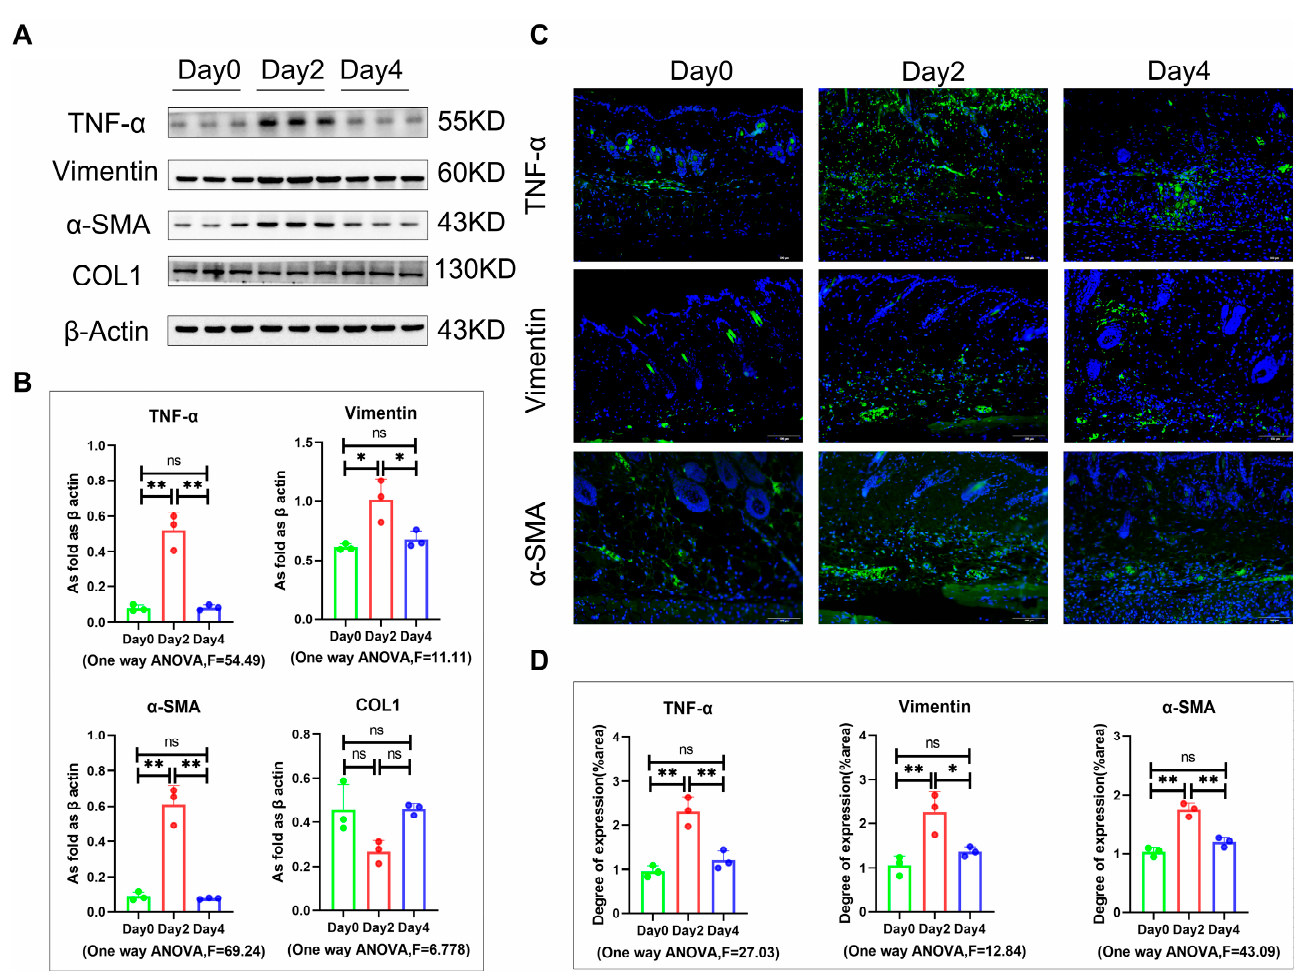
Figure 6. ( A , B ) Western blotting detected the expression of TNF- α , vimentin, α -SMA, and COL1 in the skin of mice on days 0, 2, and 4. ( C , D ) Immunofluorescence method to detect the immunofluorescence expression of TNF- α , vimentin, and α -SMA in mouse skin. Data are presented as the mean ± SD, n = 3 for each group. * p < 0.05, ** p < 0.01.